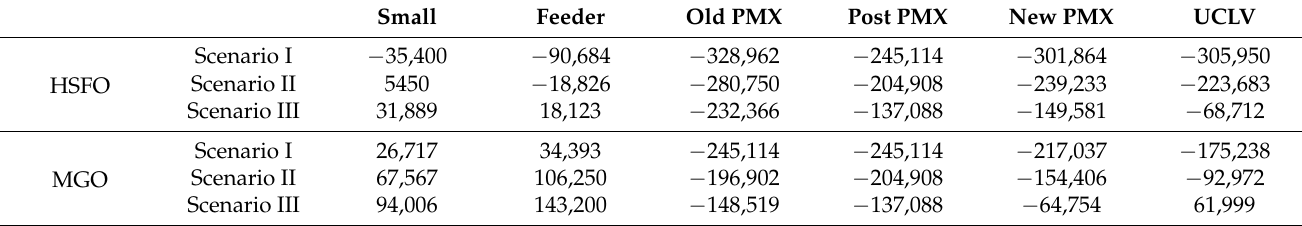
Table 5. Net present value by each segment and fuel oil type (in